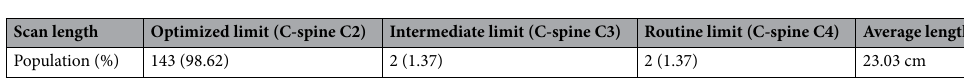
Table 1. Characteristics of acquisition coverage for all selected trauma.